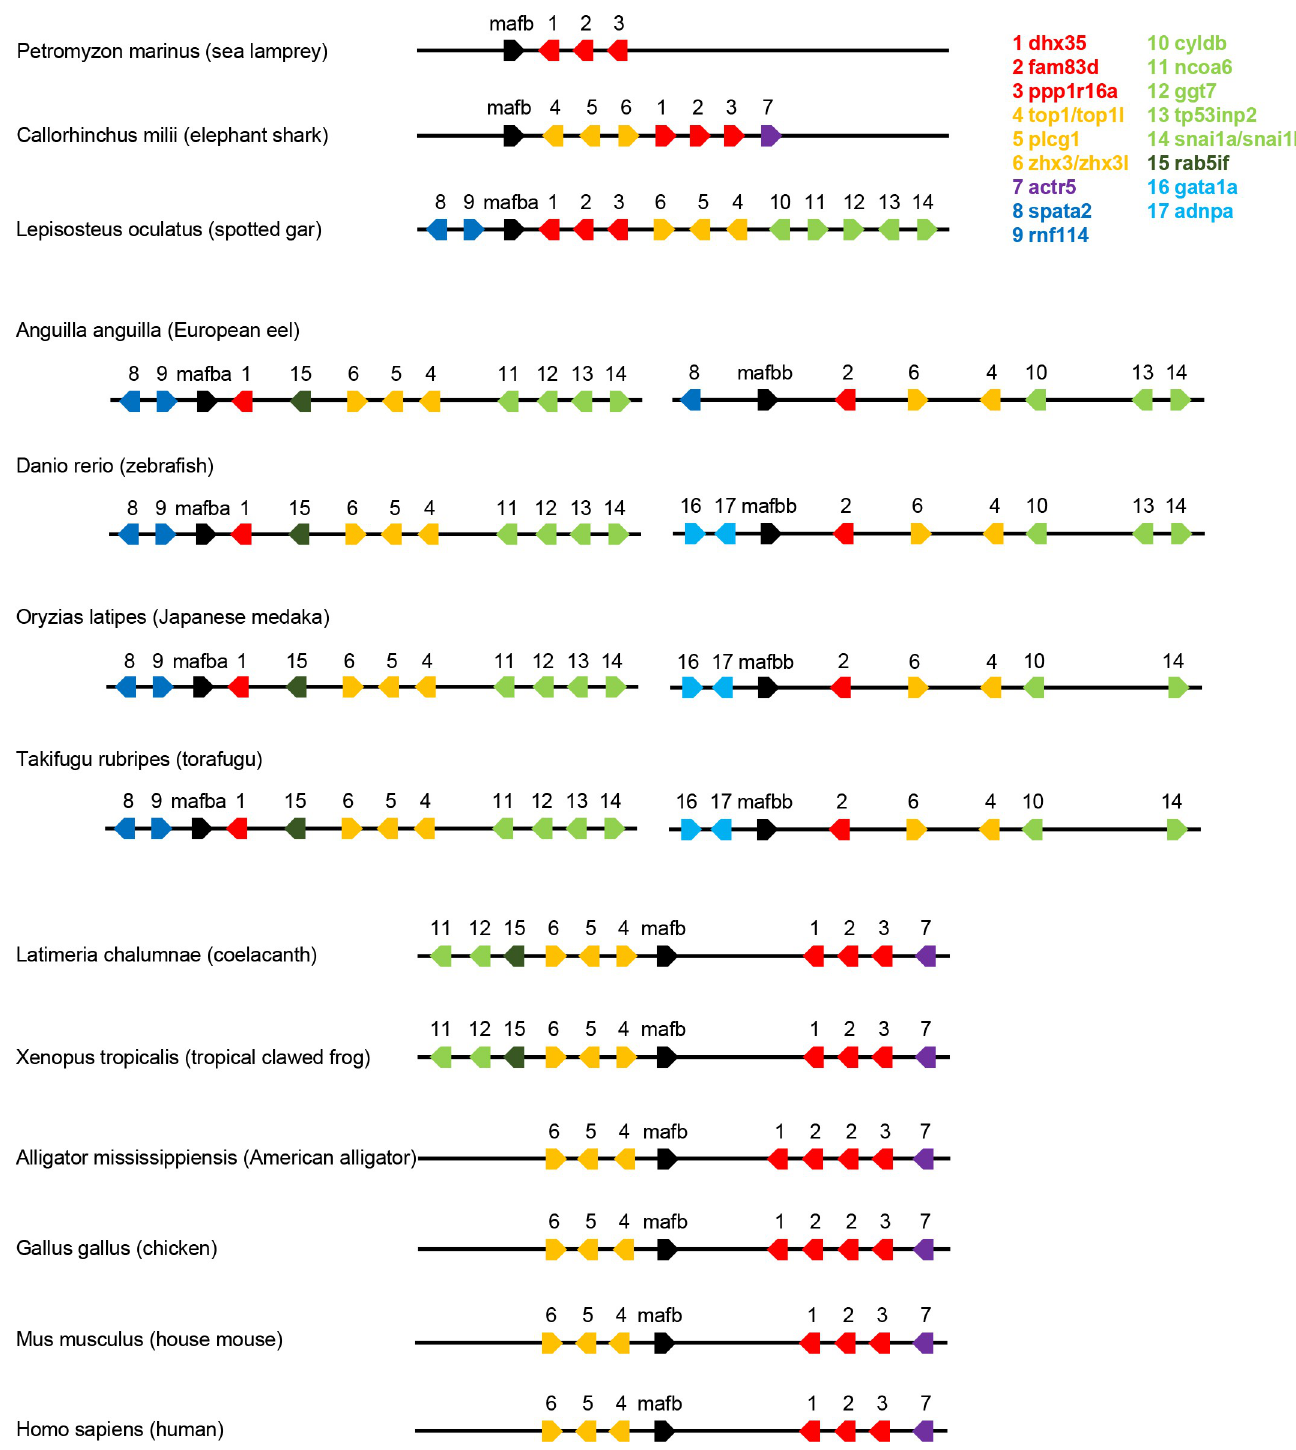
Fig 9. Gene collinearity of mafba among species at different evolutionary positions. The genes nearby mafba and their relative orders were extracted from the genomes of a wide range of vertebrates, including ancient fishes (sea lamprey, elephant shark, spotted gar, and coelacanth), modern fishes (European eel, zebrafish, Japanese medaka, and torafugu), amphibians (tropical clawed frog), reptilians (American alligator), birds (chicken), and mammals (house mouse and human). The mafba and mafbb genes appear to have originated from the ancestral gene mafb through genome duplication specifically in teleost fishes.